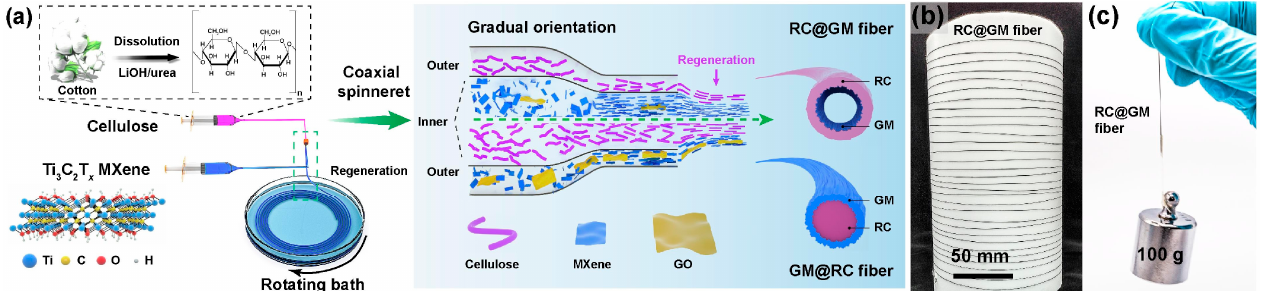
Figure 3. ( a ) Schematic illustration of coaxial spinning of hollow RC@GM fibers (upper) and solid GM@RC fibers (below); ( b ) meter-long hollow RC@GM fiber; ( c ) a single RC@GM fiber can sustain a mass of 100 g. From [48], copyright (2022), with permission from